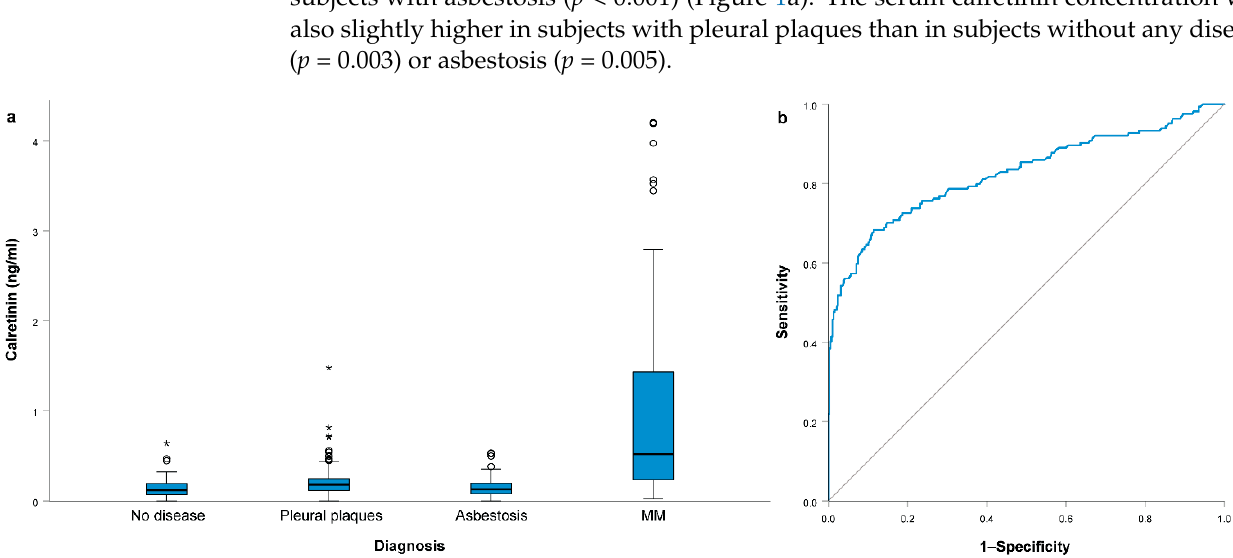
Figure 1. ( a ) Serum calretinin concentration in different subject groups; ( b ) ROC curve analysis for serum calretinin con- centration comparing malignant mesothelioma (MM) patients with all other subjects. All boxplots represent median with interquartile range, while outliers are represented using circles and extreme outliers are represented using *